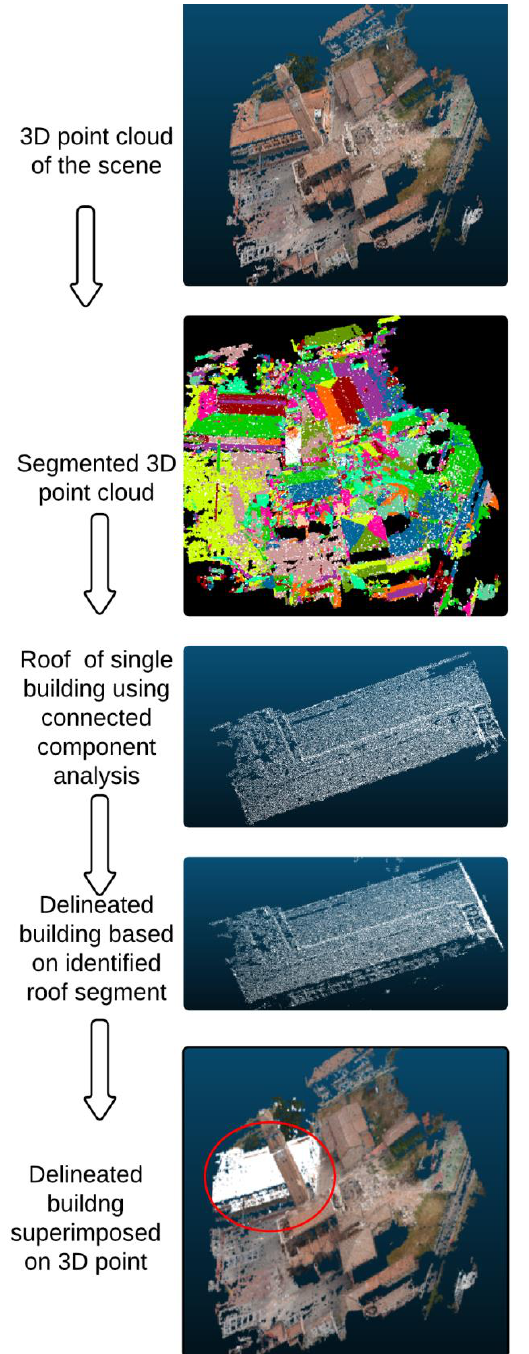
Figure 5. 3D planar segments of the delineated building from 3D point cloud are projected over the